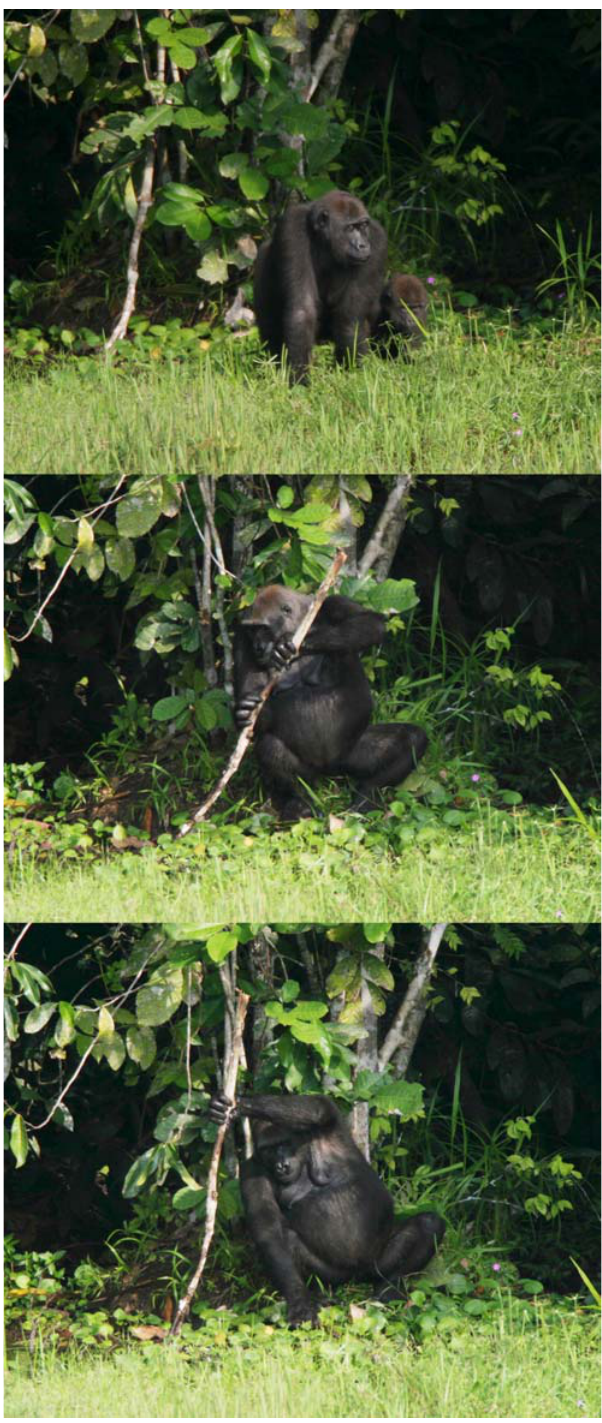
Figure 2. Female Efi Using Trunk as a Stabilizer during Food Processing at Mbeli Bai The top photo shows the intact trunk shortly before Efi manipulated it (visible to the left of female Fulani). The trunk was then detached by female Efi with both hands (middle), pushed into the ground, and used as a stabilizing stick while dredging aquatic herbs towards her with her other hand (bottom). DOI: 10.1371/journal.pbio.0030380.g002